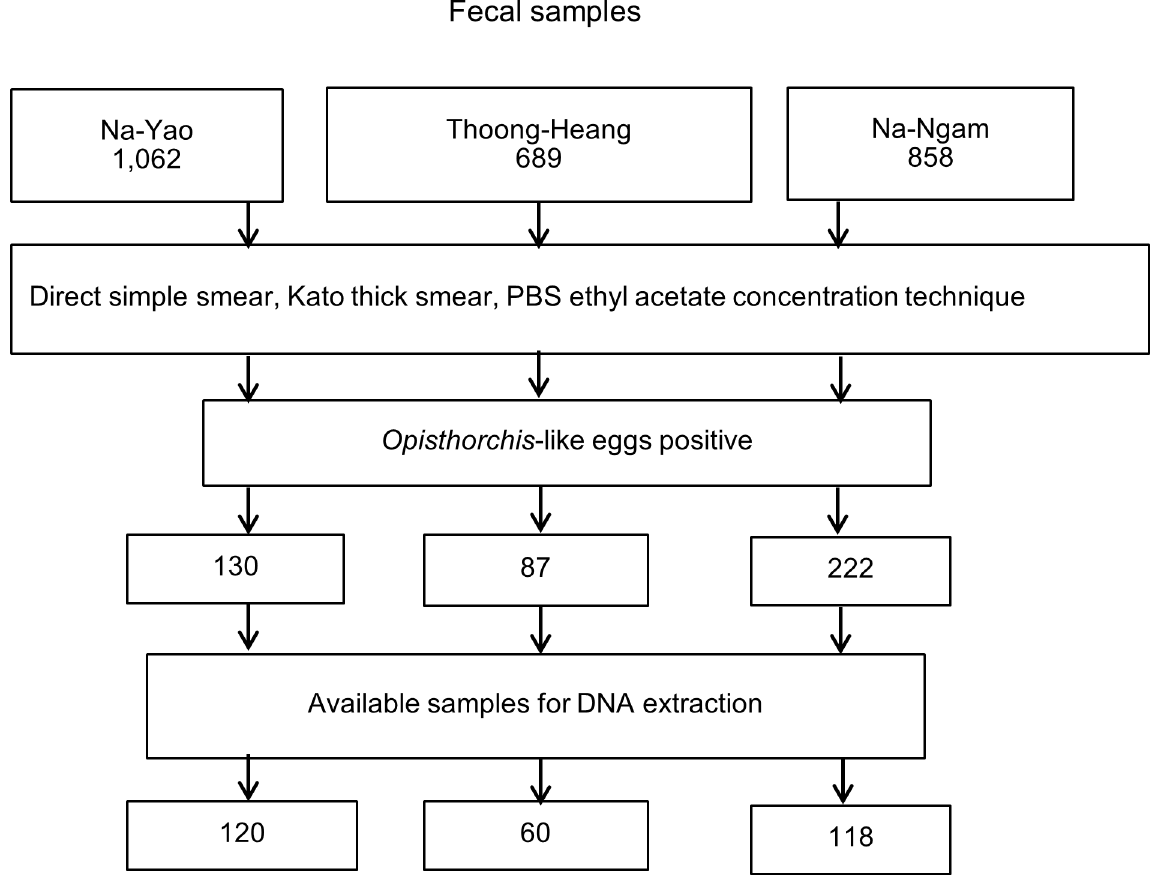
Fig 1. A flow diagram illustrating the methods used for fecal examination, Opisthorchis -like egg positive samples and available fecal samples for DNA extraction.